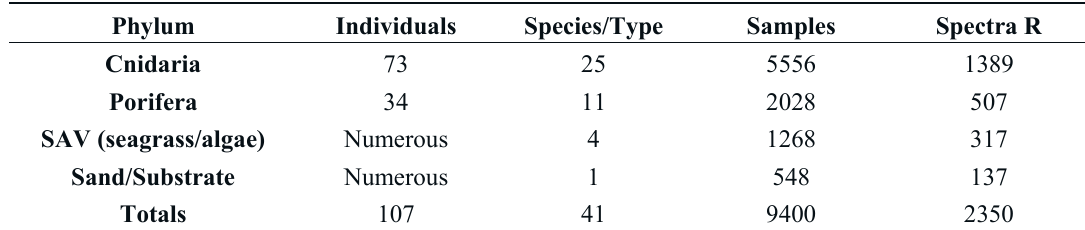
Table 1. Summary of field reflectance spectra (R) collected from shallow reef areas in southwestern Puerto Rico. Instrument configuration was set to automatically record and average four samples for each